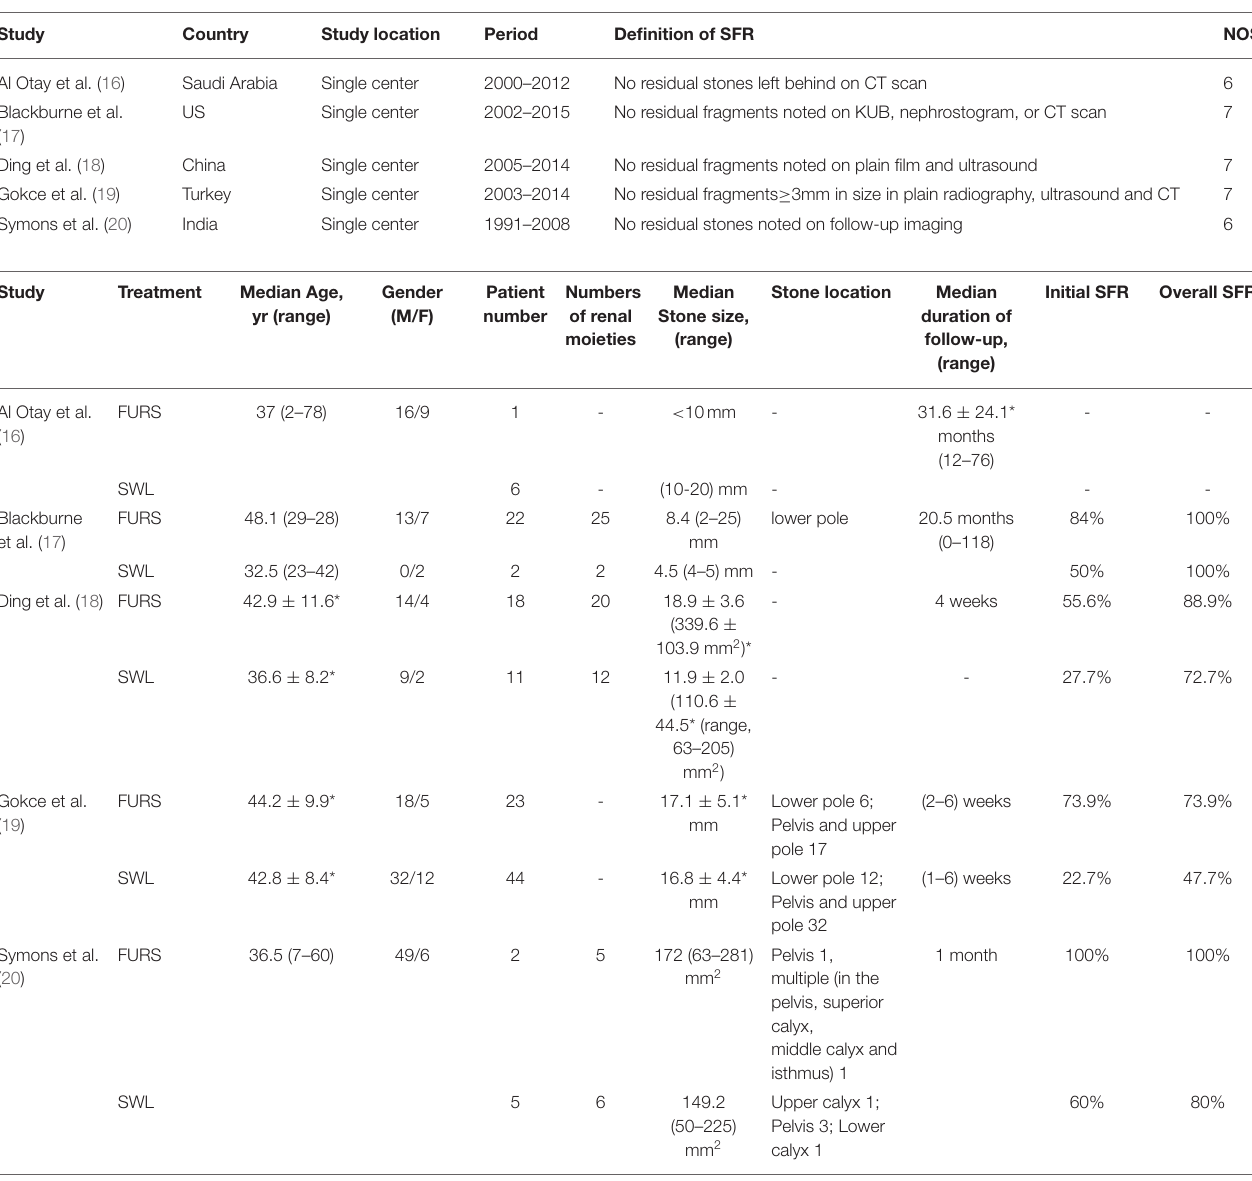
TABLE 1 | Characteristics of included